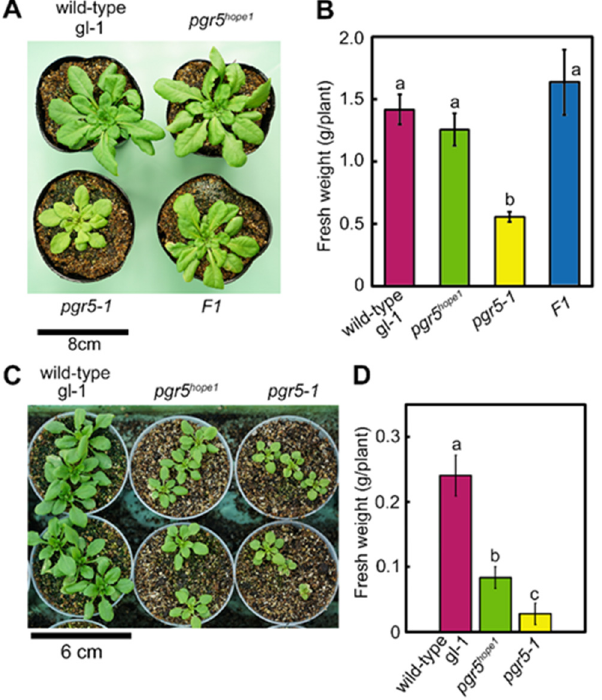
Figure 1. The difference of the growth phenotype between pgr5-1 and pgr5 hope1 . ( A ) is a picture of representative plants (wild-type (gl-1), pgr5 hope1 , pgr5-1 , and F1 hybrid of pgr5-1 and pgr5 hope1 ) grown under constant light conditions (250 µ mol-photons m − 2 s − 1 ) for 30 days. ( B ) shows the fresh weight of plants in ( A ) Data are means ± sd. ( n = 4–5) ( C ) is a picture of representative plants (wild-type (gl-1), pgr5 hope1 and pgr5-1 ) grown under natural light condition for 20 days. ( D ) shows the fresh weight of plants in ( C ). Data is means ± sd. ( n = 9) In ( B , D ), Different alphabets indicate significant differences analyzed by Tukey’s HSD-test. ( p < 0.05) Experiments were independently repeated at least 3 times and showed similar results. Figures showed the representatives.